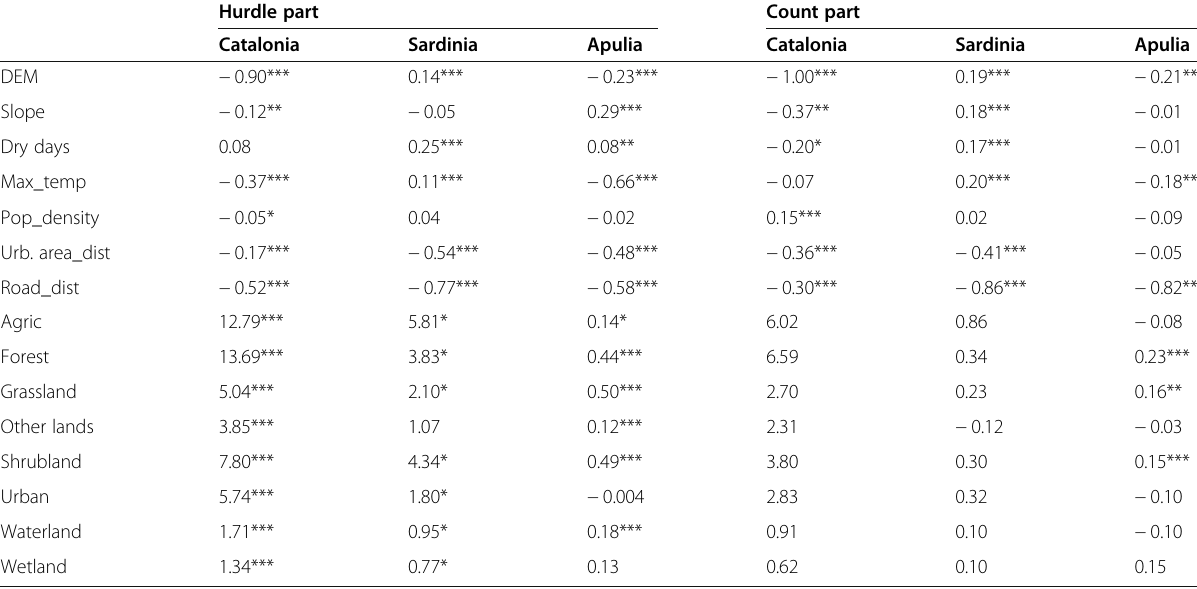
Table 3 Coefficients of the Negative Binomial Hurdle model (hurdle and count parts) for each independent variable across the three study regions Hurdle